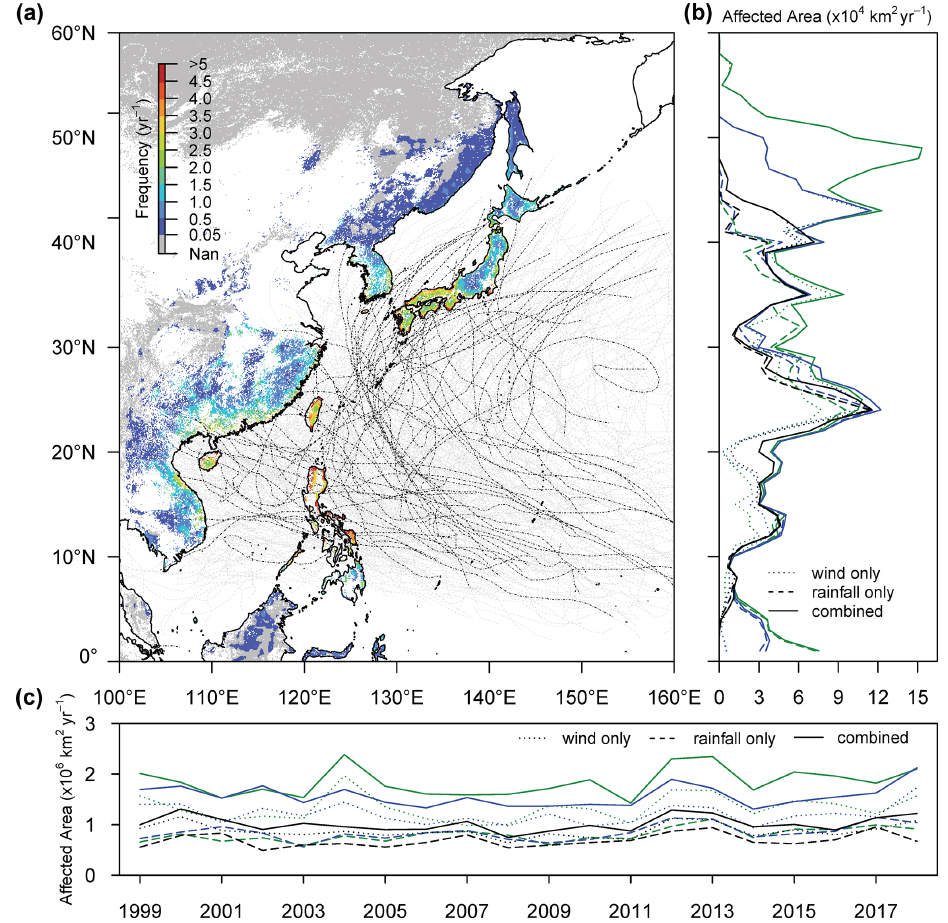
Figure A1. Spatial and temporal patterns of potential forest damage by tropical cyclones in East Asia. (a) Return frequency (yr − 1 ) of tropical cyclones between 1999 and 2018 following a combined wind–precipitation definition considering three diameters to define the width of the storm track (definition 3a in Table A1). Since 1999, 2240000 ± 690000km 2 of forest in the study region experienced conditions that may have resulted in cyclone-driven damage, at least once every decade. No less than 540000 ± 260000km 2 , including 70% of the tropical forest in the region, experienced potentially damaging conditions at least once per year and are thus classified as being under chronic wind stress. Forests unlikely to have experienced a tropical cyclone between 1999 and 2018 are shaded in gray. For land locations shown in white, the forest is not the dominant land cover. The dot–dashed lines show the cyclone tracks between 1999 and 2018. The black lines indicate the events that passed the quality control criteria used in this study. (b) Latitudinal gradients of potentially damaged forest area (km 2 yr − 1 ) between 1999 to 2018 for all nine definitions of affected area. Damage potential is the outcome of an interplay between cyclone frequency, cyclone intensity, and the presence of forests. The different definitions of affected area (Table A1) consistently show a high potential for forest damage over island and coastal regions located between 10 and 35 ◦ N. This high potential is largely driven by the frequency of tropical cyclones (Fig. A2), i.e., two or more cyclones making landfall per year. Depending on how the affected area is defined, there is a second region located between 40 and 50 ◦ N with a high potential for storm damage. In this region, the potential damage is the outcome of the high forest cover resulting in a strong dependency on the assumed width of the storm track (Fig. A2). (c) Temporal dynamics of the total potentially damaged forest area (km 2 yr − 1 ) for all nine definitions of affected area. Irrespective of the definition of the affected area, the coefficient of variation in the between-year variation in potentially damaged areas ranged from 15% to 20%. Excluding the four most powerful typhoons that occurred in the region since 1999 changed the average coefficient of variation from 17% to 16%. This suggests that the most powerful typhoons make only a small contribution to the total annually potentially affected area in the region. Likewise, a recent literature review reported that 66% of the research papers in this area have examined the effects of only about 6% of the most powerful cyclones (Lin et al., 2020). The relatively small contribution of those events to the potential damage area suggests that in regions with frequent tropical storms, disturbance ecology would benefit from broadening its scope by examining the effects and recovery of a representative sample of tropical cyclones rather than focusing on the most devastating